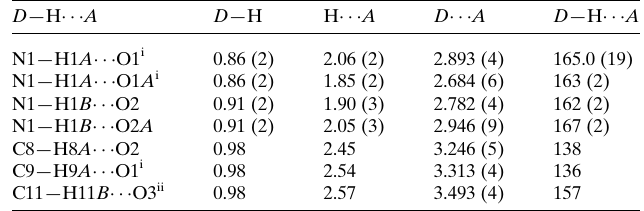
Table 1 Hydrogen-bond geometry (A˚ , (cid:5) ).